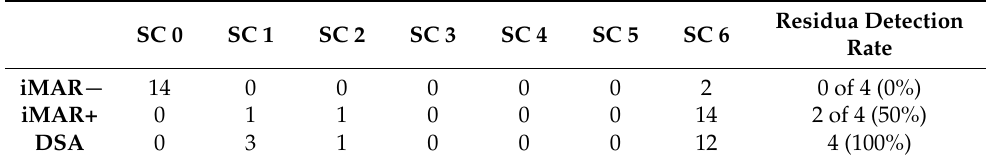
Table 6. Aneurysm occlusion grading in IAs treated via